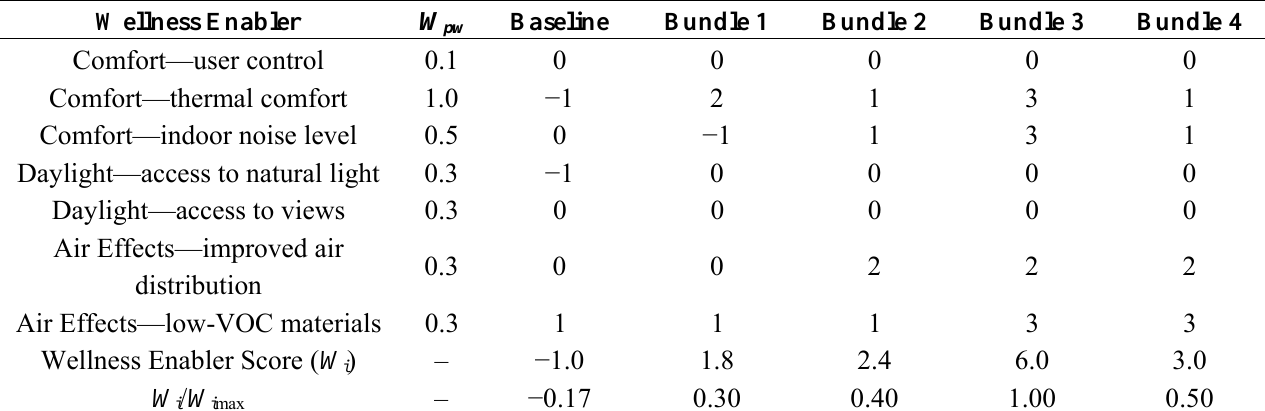
Table 7. Wellness enabler potential